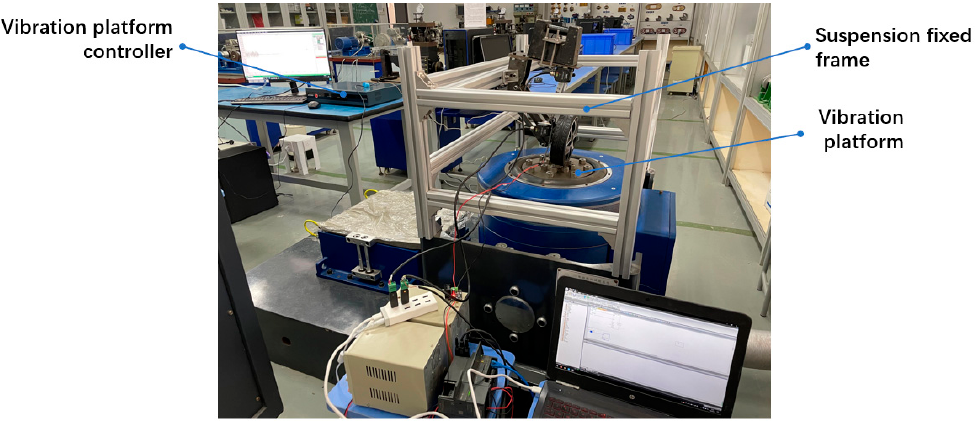
Figure 8. Connection of the suspension system and the vibration platform. The relevant experimental equipment brands and models are shown in Table 2. Experimental equipments brands and models.